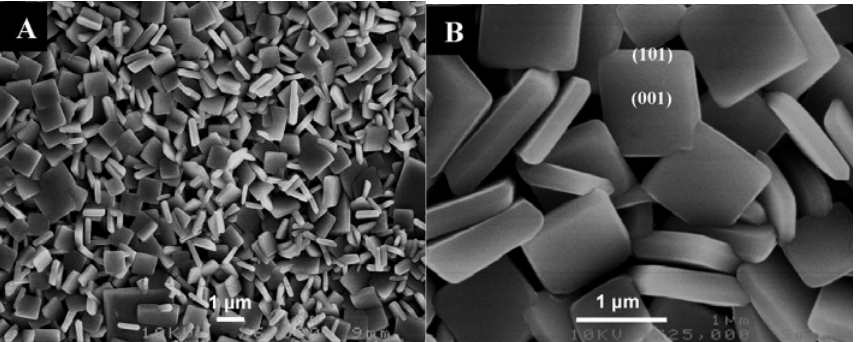
Figure 4. Typical SEM images of anatase TiO a synergistic capping agent. Reprinted with permission from ref. [30]. Copyright 2009 American Chemical